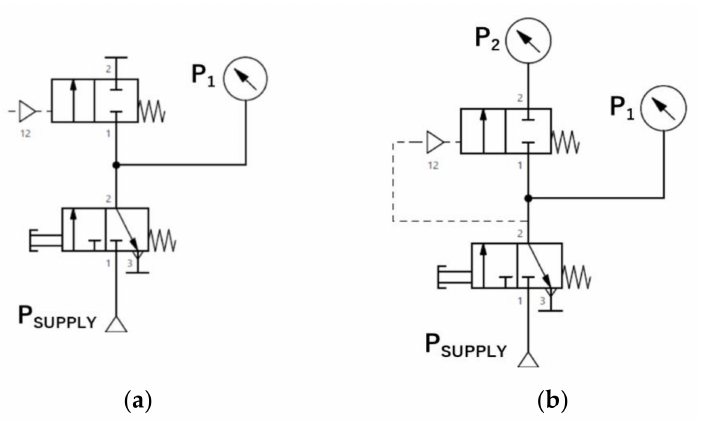
Figure 9. Pneumatic circuits adopted in the experimental activity for checking the pneumatic seal of: ( a ) chamber A and ( b ) chamber